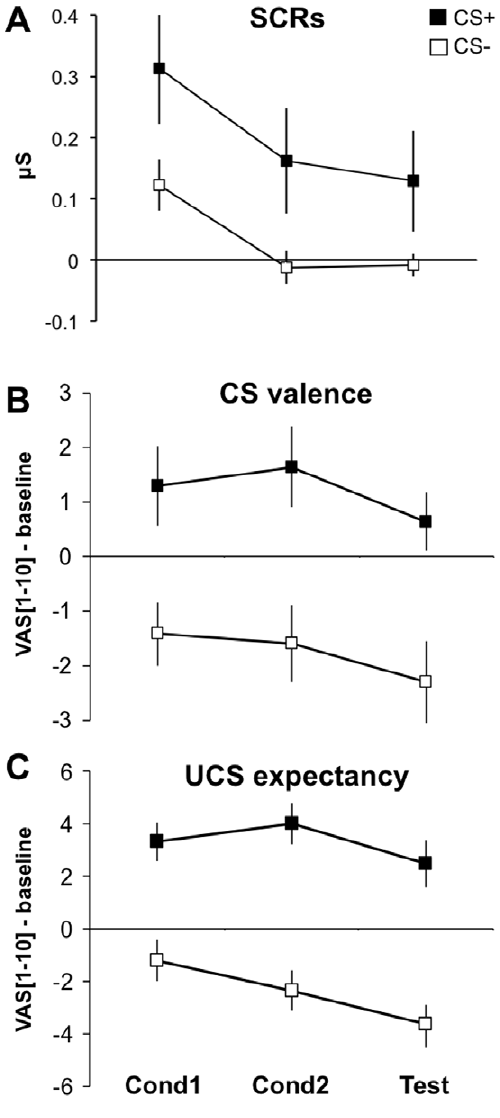
Figure 3. Uninstructed fear (study 2): Behavior. SCRs ( A ), CS valence ( B ), and UCS expectancy ( C ) during the two conditioning runs (UF-Cond1, UF-Cond2) and the test run (UF-Test). SCR analysis ( A ) was restricted to unpaired CS + s and CS 2 s, and responses were averaged across each run. Rating data ( B, C ) are normalized to the baseline rating given after habituation and before conditioning. Responses to the refresher CS at the outset of the UF-Test run (see Methods ) are not shown. VAS, visual analog scale. Error bars: s.e.m.